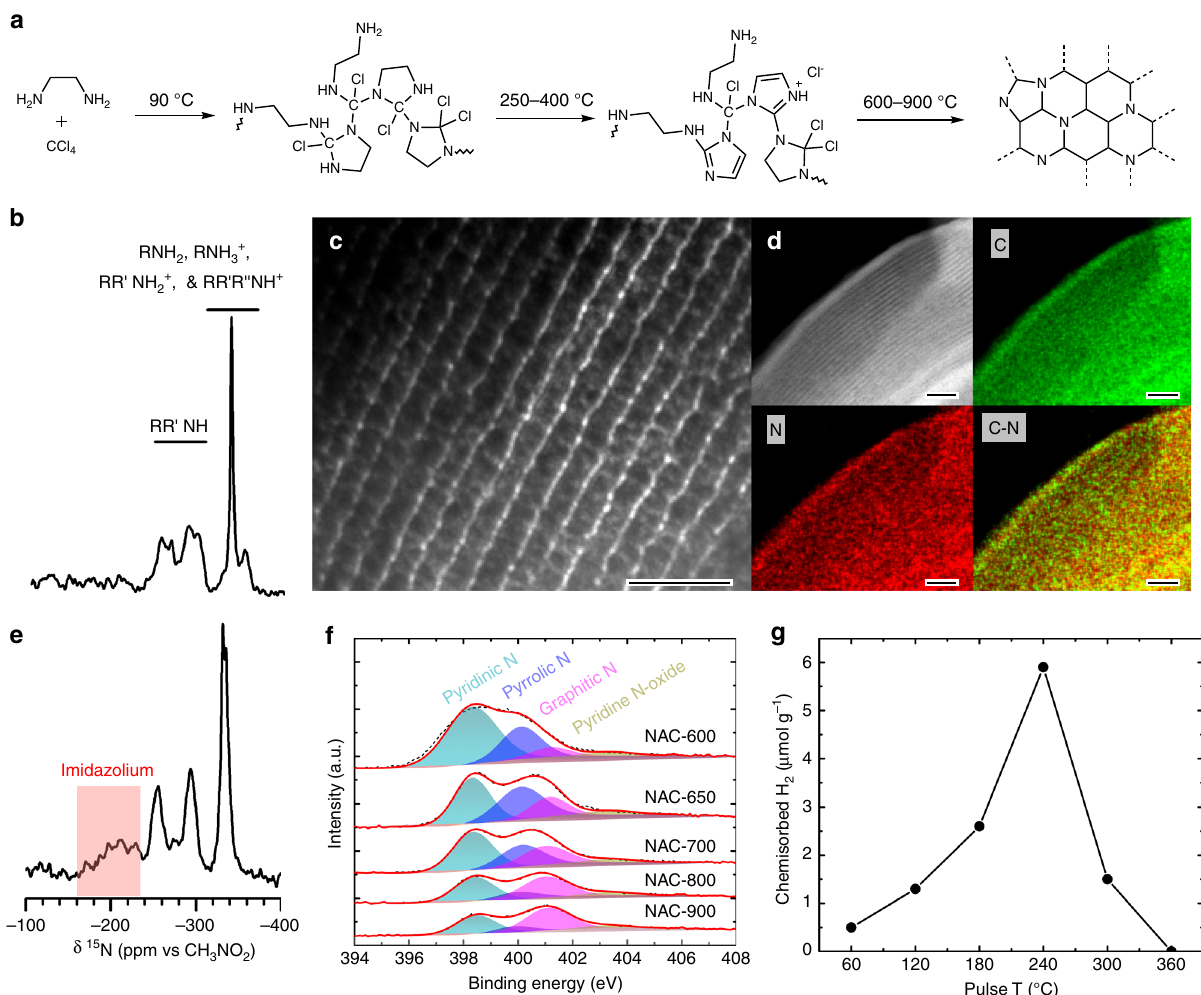
Fig. 1 Characterization of metal-free carbocatalyst. a Proposed formation mechanism of NAC catalysts inside the mesoporous silica template. b DNP- enhanced 15 N{ 1 H} CPMAS spectrum of polymer prior to carbonization. c TEM image of NAC-800, where 800 represents the sample preparation temperature. Scale bar, 40nm. d HAADF-STEM image and EDS mapping of C and N of NAC-800. Scale bar, 40nm. e DNP-enhanced 15 N{ 1 H} CPMAS spectrum of condensed polymers calcined for 10min at 300°C. f N1 s XPS spectra of NAC catalysts synthesized at different carbonization temperatures, showing pyridinic N (green), pyrrolic N (blue), graphitic N (magenta), and pyridine N-oxide (brown). g Pulsed H 2 chemisorption of NAC-800 at 60 –